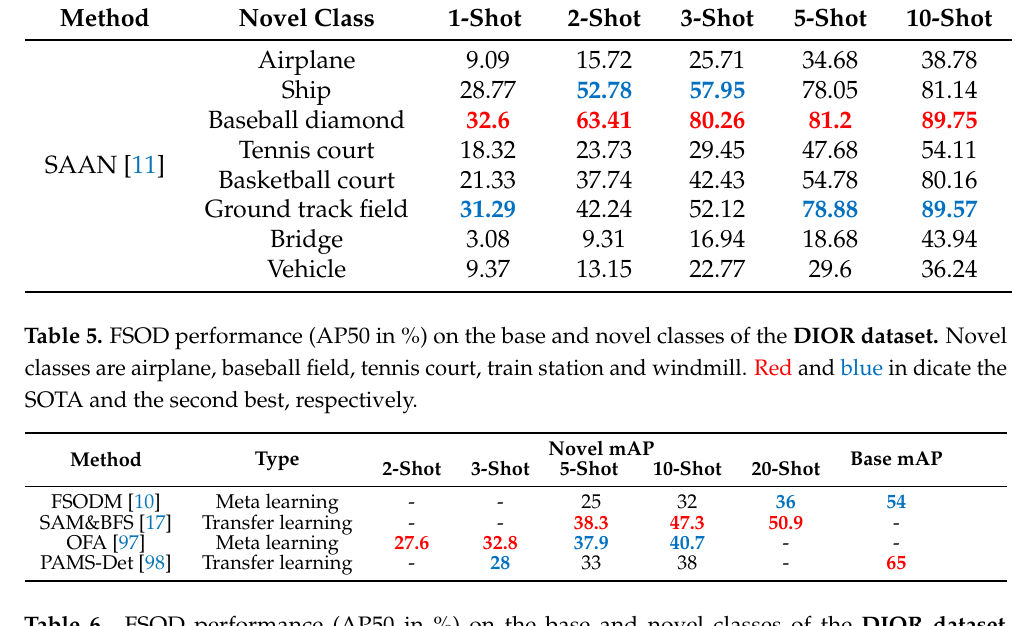
Table 6. FSOD performance (AP50 in %) on the base and novel classes of the DIOR dataset . The base/novel splitting can be found in Table 1. Red and blue indicate the 1st and 2nd high- est accuracy, respectively. P-CNN is a meta learning-based few-shot detector.